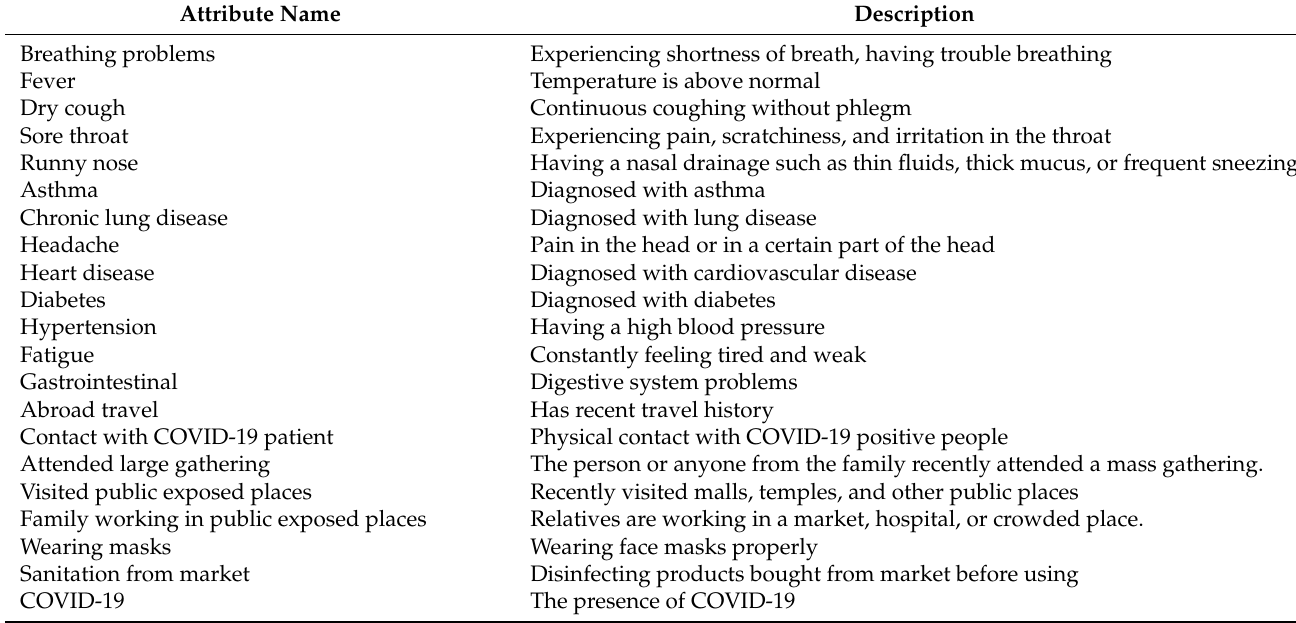
Table 2. COVID-19 predictors and descriptions of the COVID-19 symptoms and presence dataset